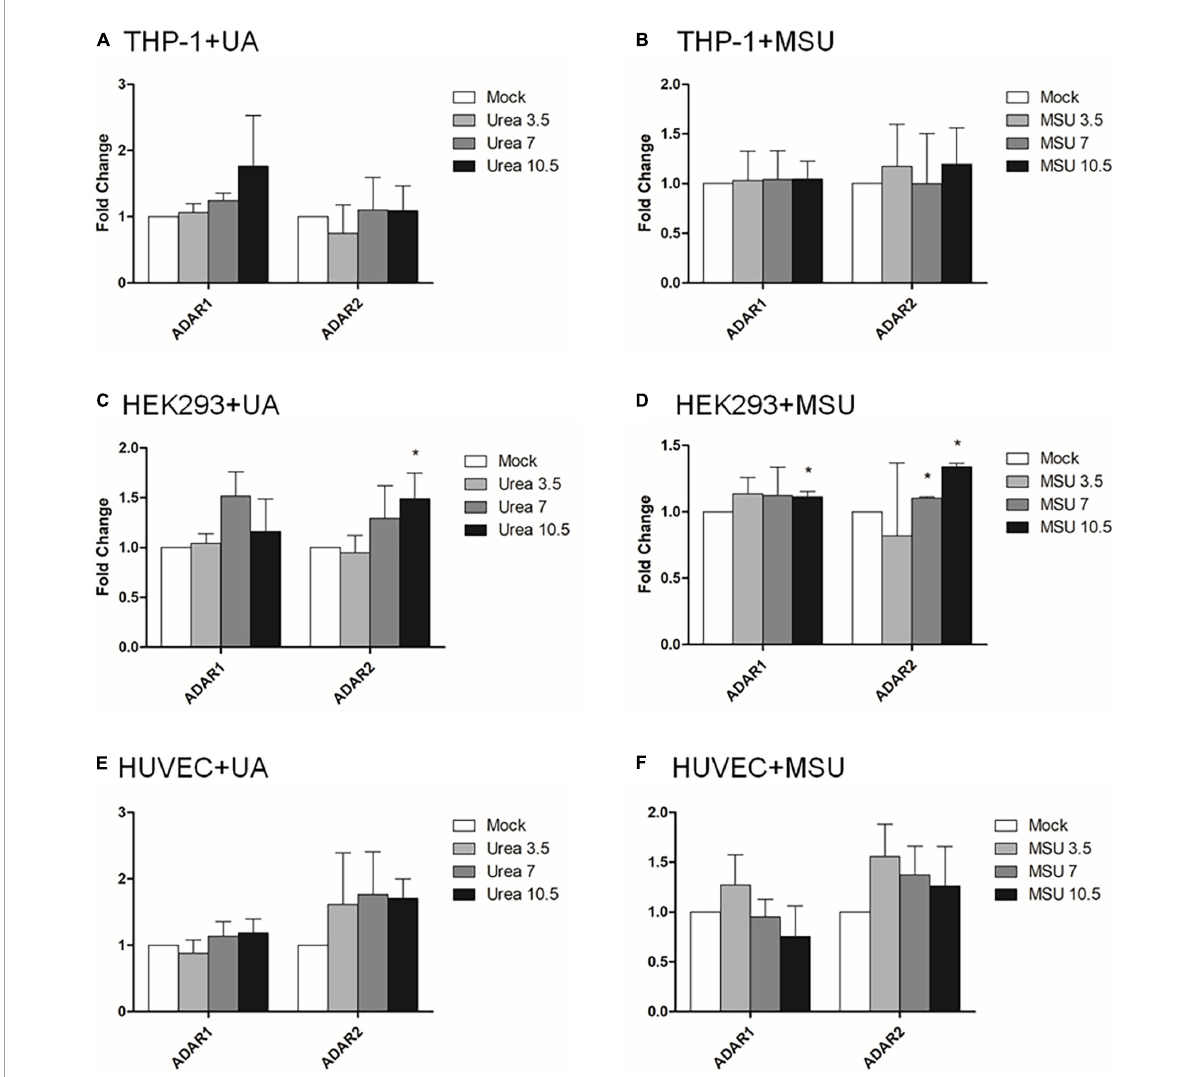
FIGURE3 RNA expressions of RNA editing enzymes were affected in MSU- or UA-treated HEK293 cells. The expressions of ADAR1 and ADAR2 in UA-treated THP-1 cells (A) , MSU-treated THP-1 cells (B) , UA-treated HEK293 cells (C) , MSU-treated HEK293 cells (D) , UA-treated HUVEC cells (E) , and MSU-treated HUVEC cells (F) were quantitated through real-time PCR. Error bars represent standard deviation. The results of three independent experiments were averaged to obtain the final results. * P < 0.05 by Student’s t -test, compared with mock cells.